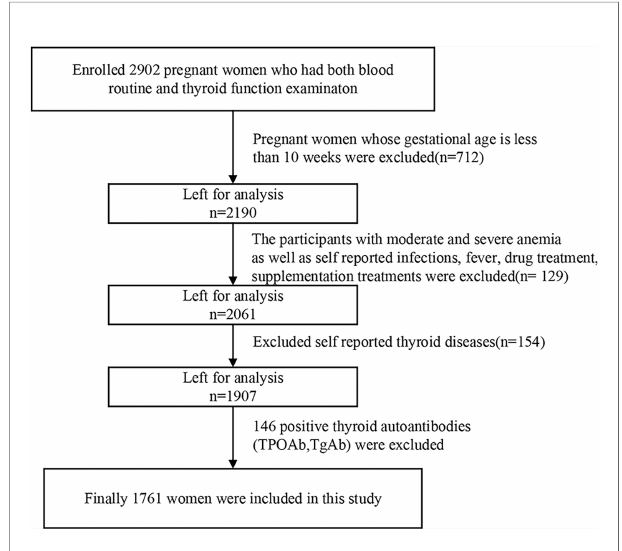
FIGURE 1 | Flowchart of participants screening